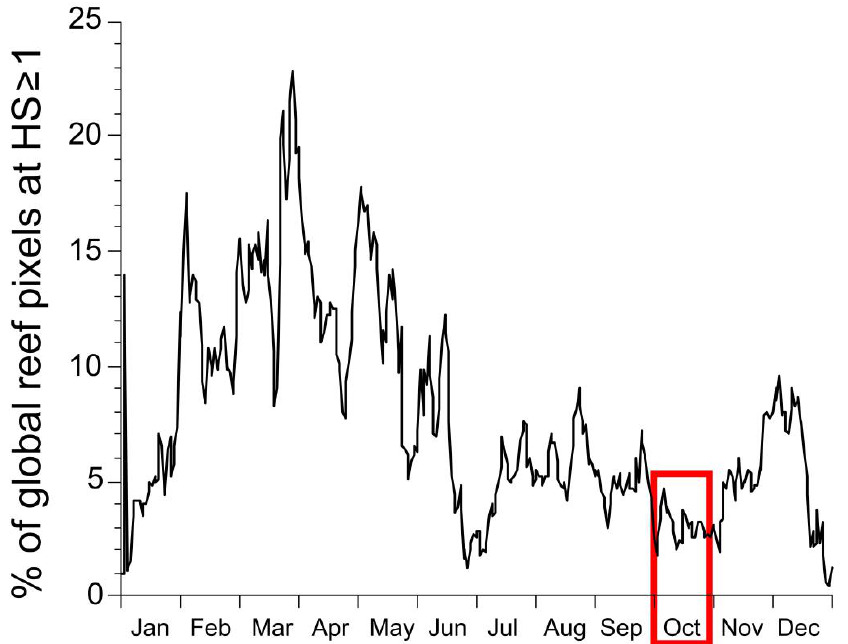
Figure 3. Percentage of global coral reef pixels at HS ≥ 1 for 2016. Note that the red box represents the transition period from the Geo-Polar SST reanalysis to the NRT Geo-Polar SST, which took place from 1 to 28 October 2016. As the Geo-Polar SST reanalysis extended back to 1 September 2002, November 2002 was